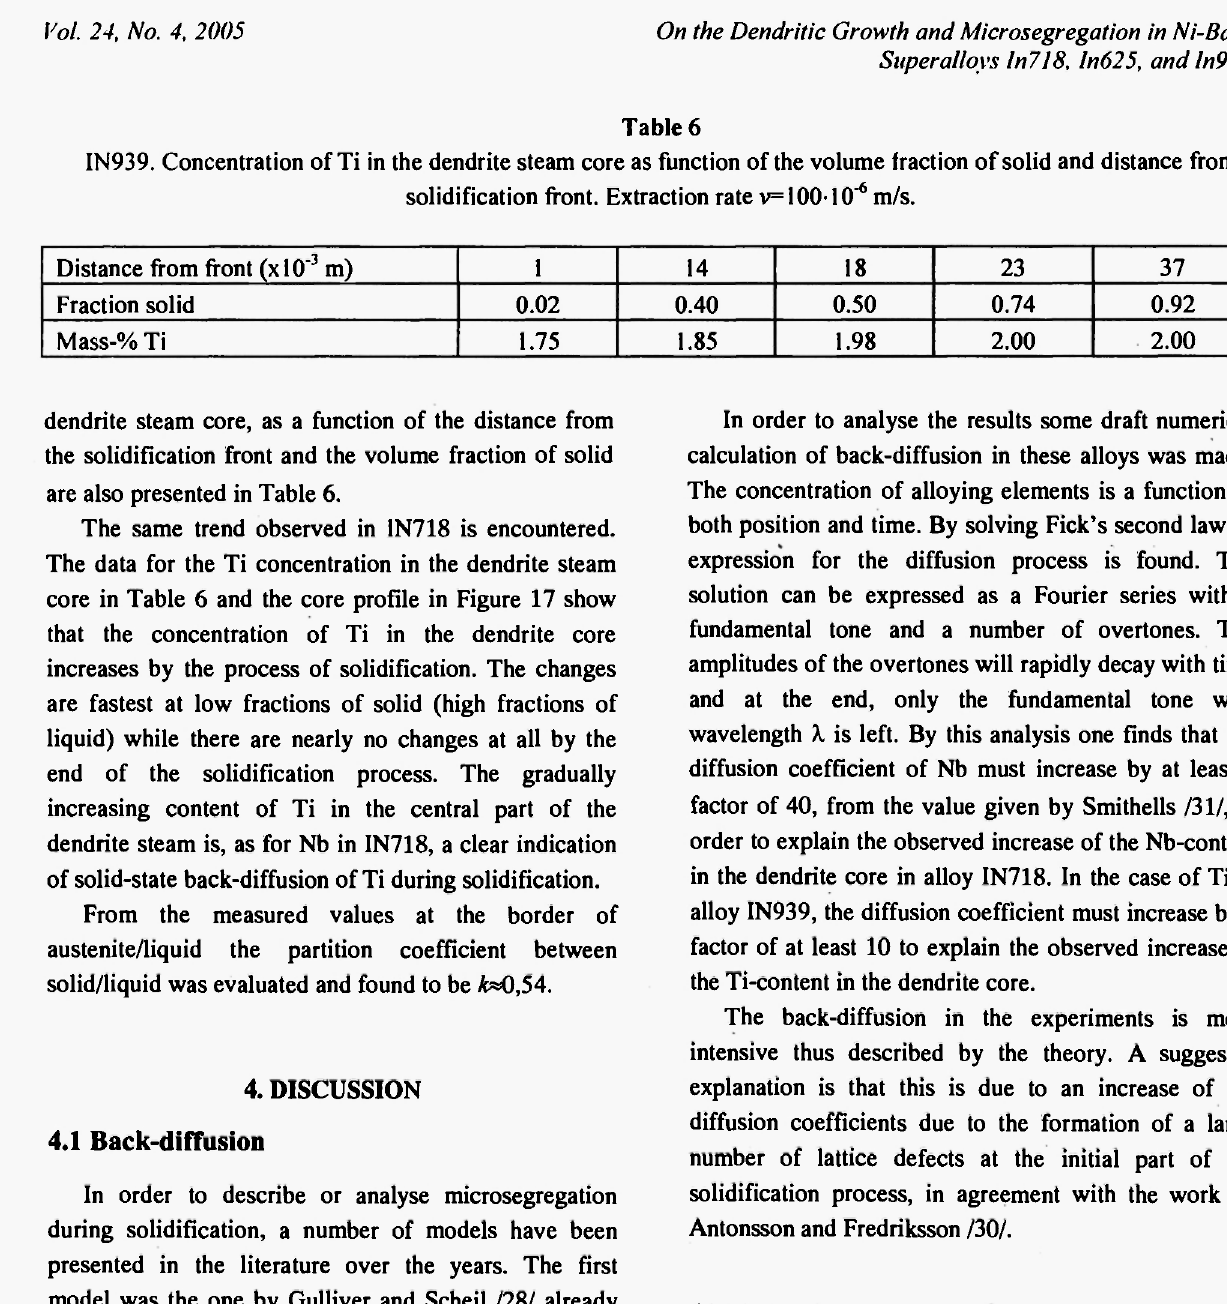
IN939. Concentration of Ti in the dendrite steam core as function of the volume fraction of solid and distance from solidification front. Extraction rate v= 100· 10" 6